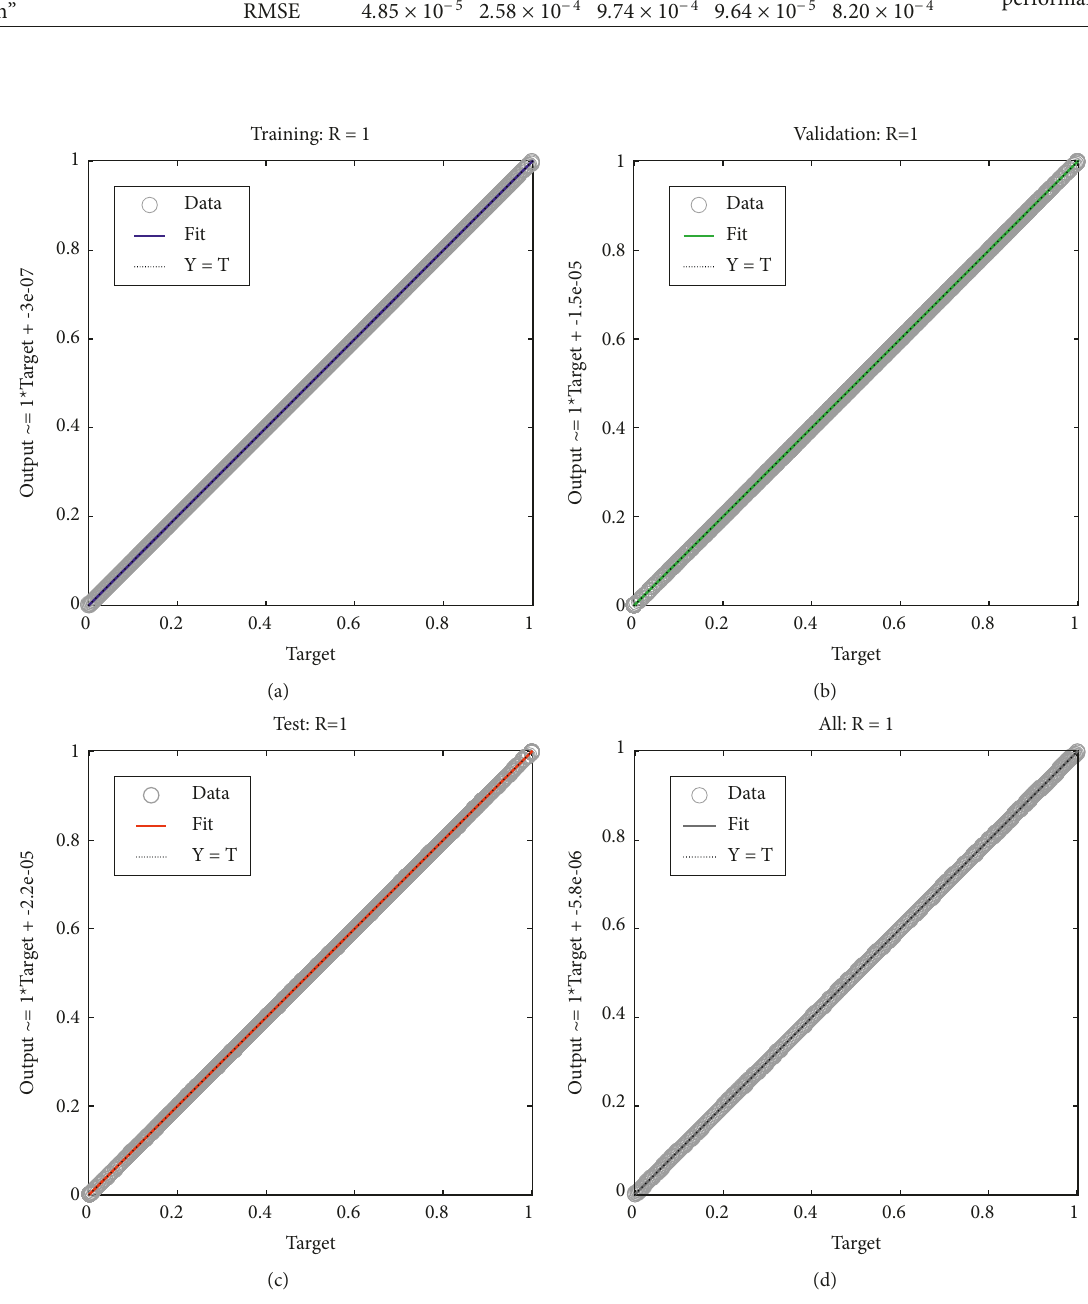
Figure 10: Regression plots for the BPNN training, testing, and